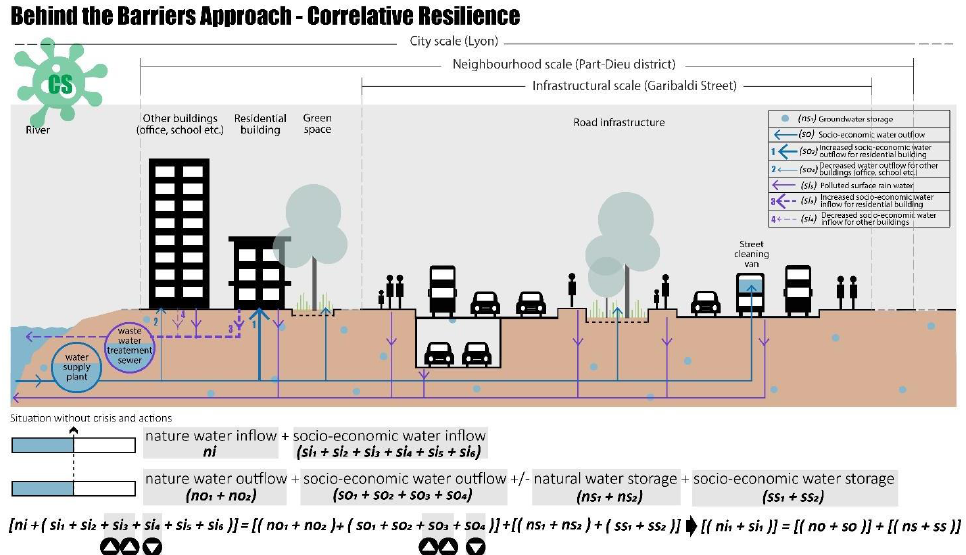
Figure 10. Behind the “barrier”, correlative resilience in COVID-19 scenario, realised by authors.